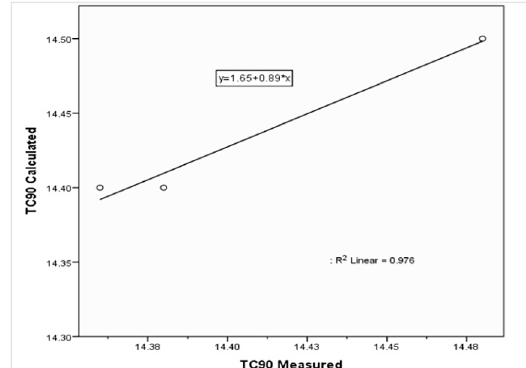
vs. TC Measured 90 90